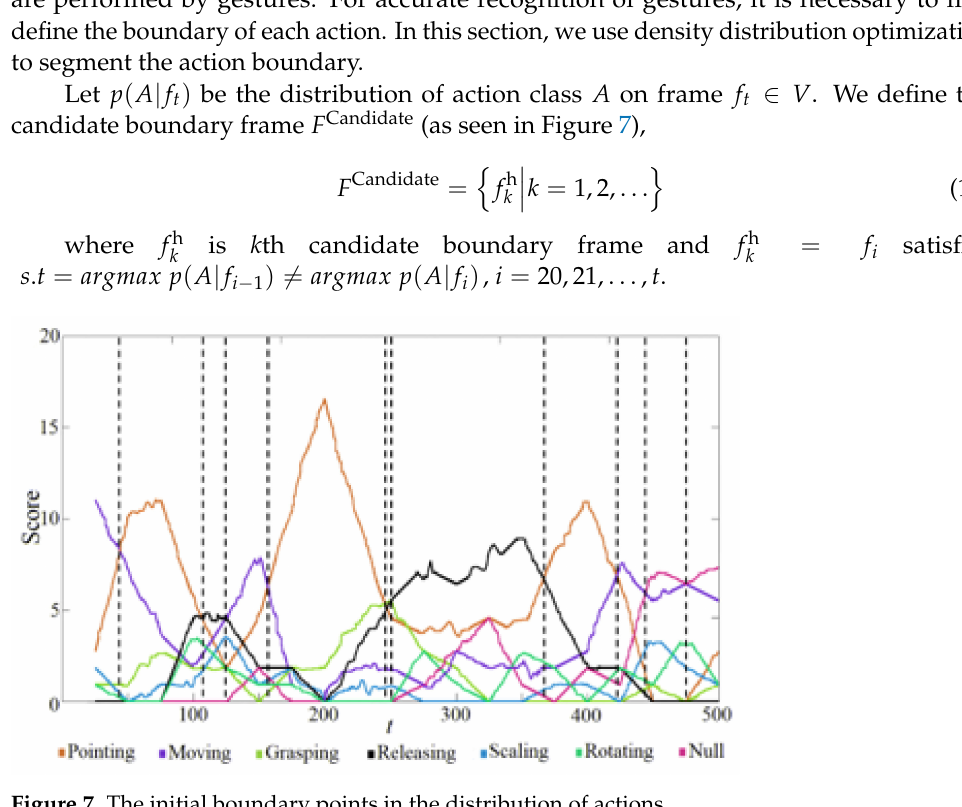
Figure 7. The initial boundary points in the distribution of